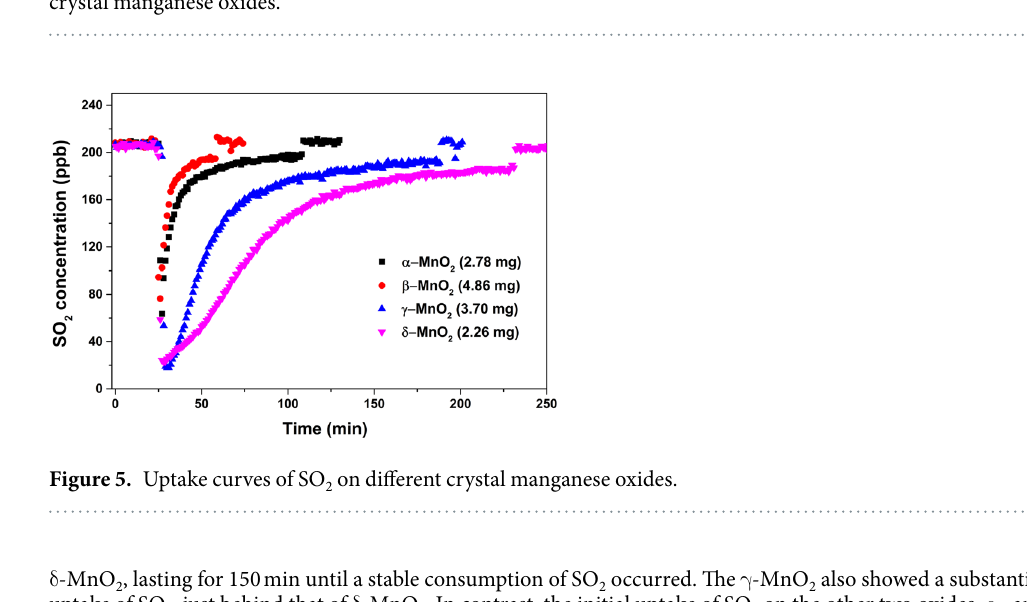
Figure 4. Comparison of integrated areas ranging 1552–782 cm − 1 for the sulfate species formed on different- crystal manganese oxides.